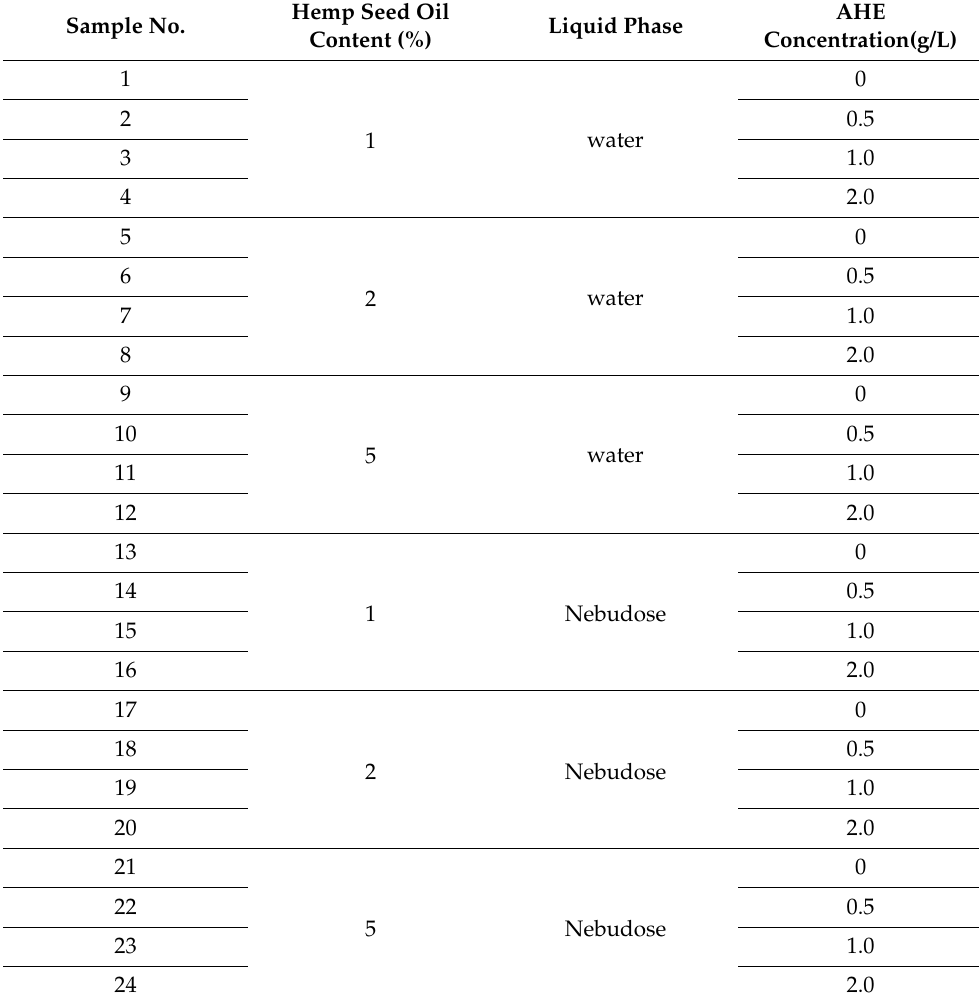
Table 1. Content of the prepared emulsion